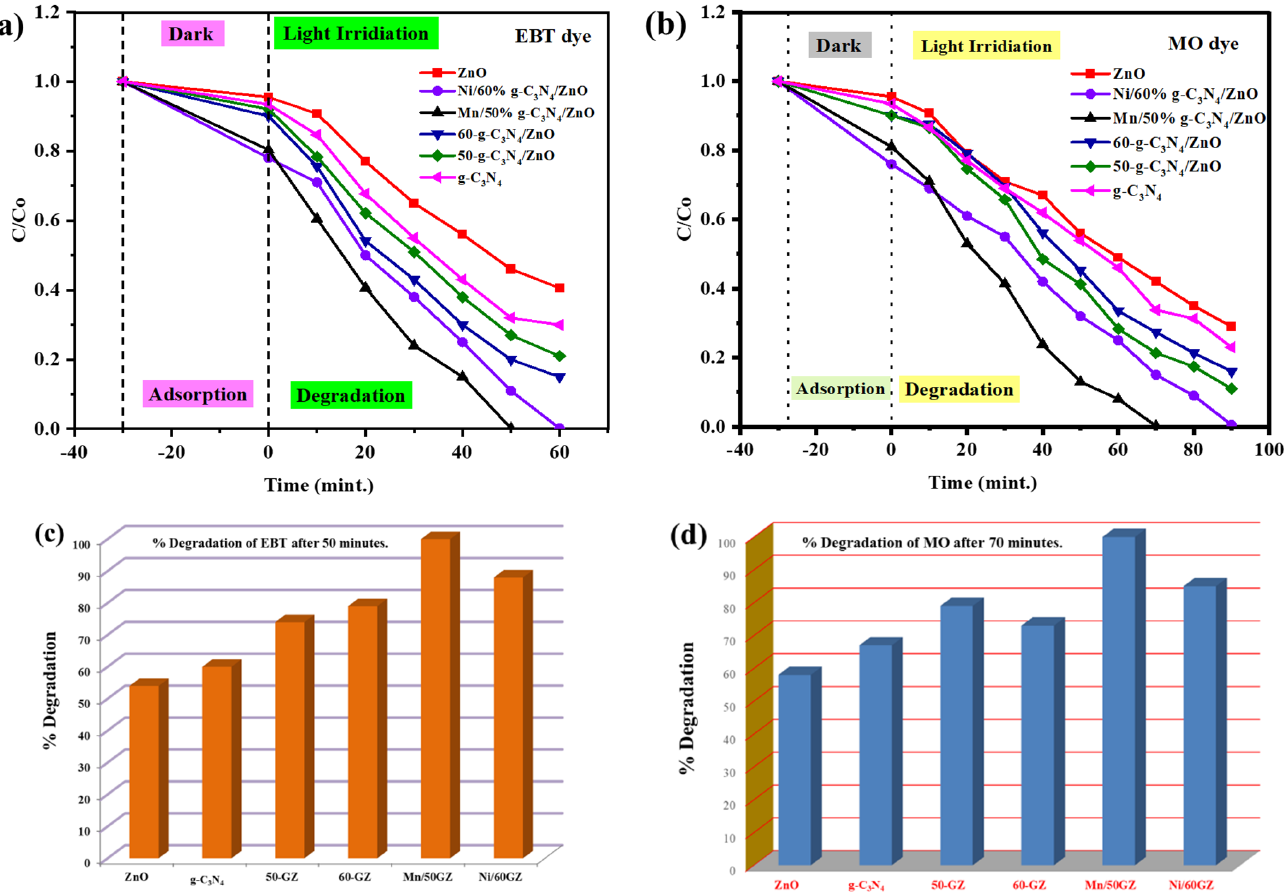
Figure 9. Photocatalytic dye decoloration rates of EBT ( a ) and MO ( b ) and bar graphs of the percentage of decoloration of EBT ( c ) and MO ( d ) by Ni/60GZ, Mn/50GZ, 50-GZ, 60-GZ, and g-C 3 N 4 . The kinetics of EBT dye decolorization are explained by the Langmuir-Hinshelwood model for ZnO, g-C 3 N 4, Ni/60GZ, Mn/50GZ, 60% g-C 3 N 4 /ZnO, and 50% g-C 3 N 4 /ZnO NCs,